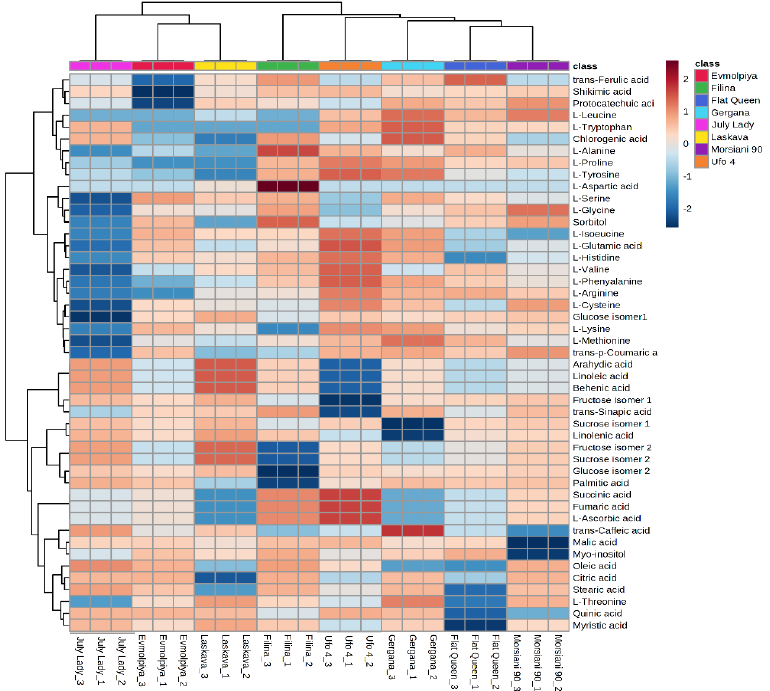
Figure 4. Clustering result of peach varieties shown as a heatmap. The color scale of the heatmap ranges from dark brown (value: +2) to dark blue (value: − 2). The values were normalized by log 10 transformation.